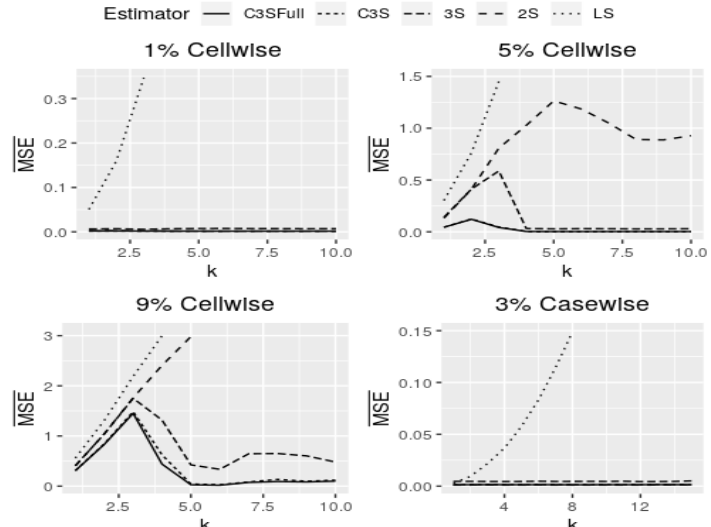
Figure 5. MSE for indicated cell-wise and case-wise contamination values k in models with continuous and dummy covariates and n = 1000. Source: the